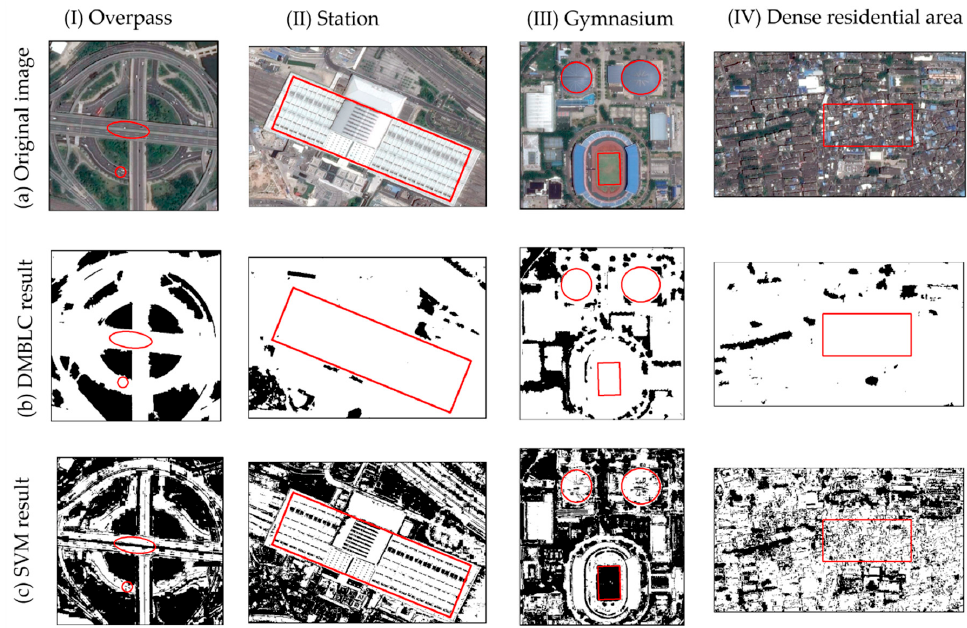
Figure 5. The ISA result in four subsets of the study area: ( I ) Overpass; ( II ) Station; ( III ) Gymnasium; and ( IV ) Dense residential area. The rows are: ( a ) the original Google Earth image; ( b ) the DMBLC-extracted ISA result; and ( c ) the SVM-extracted ISA result. In row ( b , c ), white pixels indicate ISA, and black pixels indicate non-ISA.